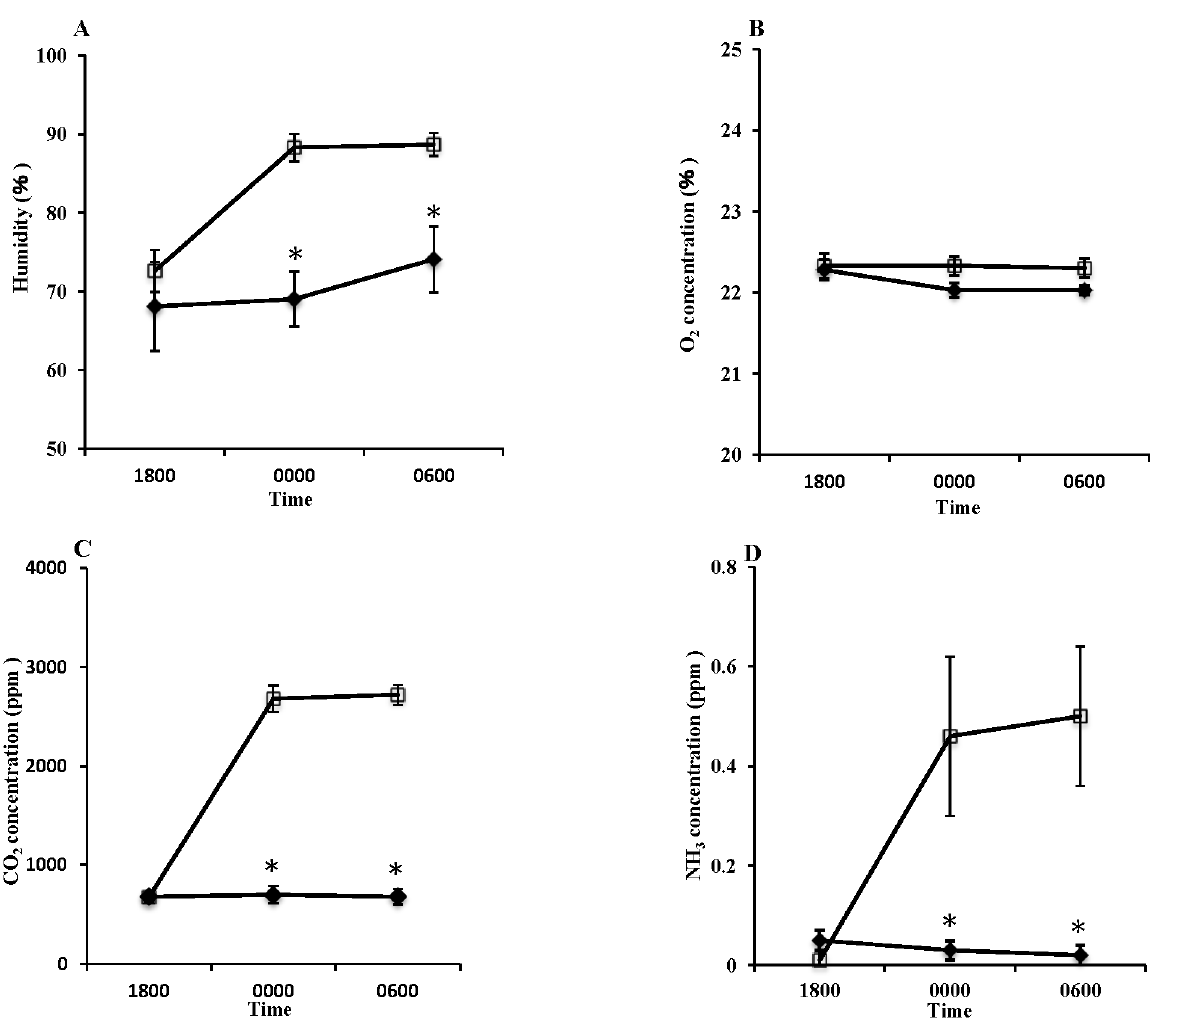
Figure 3. Changes in the dairy barn environment in unventilated (UV □ ) and tunnel-ventilated (TV ♦ ) systems. (A) Humidity, (B) O and (D) NH concentration. Values represent the mean±standard error (n = 21). * Represents statistical difference with respect to TV at 3